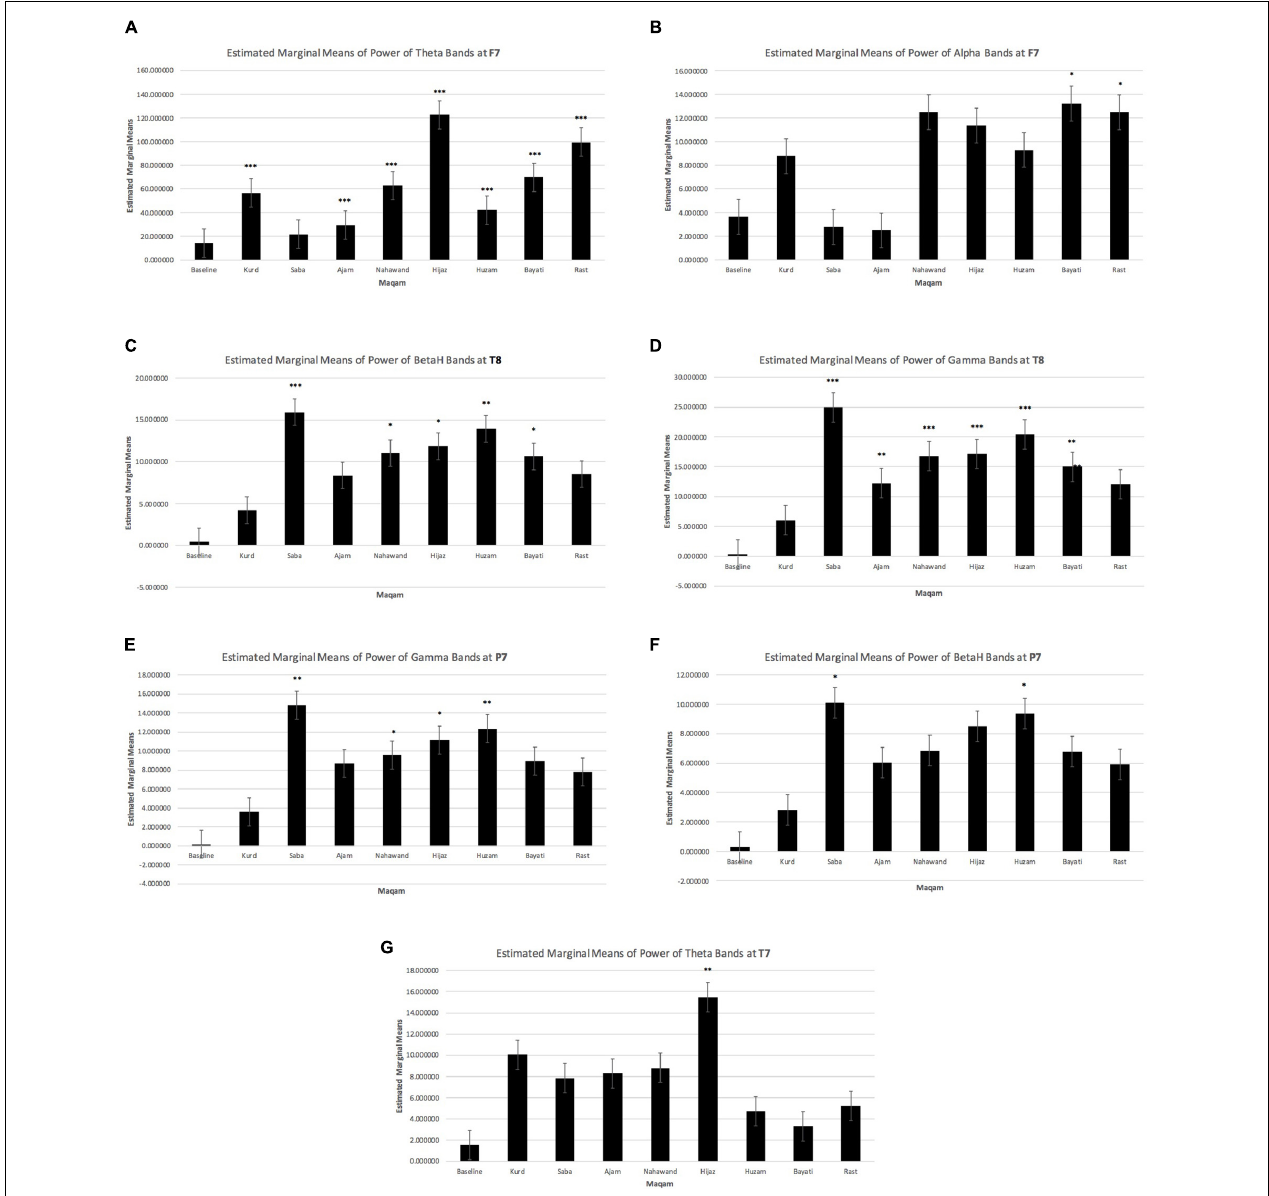
FIGURE 2 | Left fronto-temporal increase of low frequency bands and parietal left and temporal right increase of high frequency bands during improvisations for each maqam as compared to the baseline. (A) Theta bands at F7. (B) Alpha bands at F7. (C) Beta high bands at T8. (D) Gamma bands at T8. (E) Gamma bands at P7. (F) Beta high bands at P7. (G) Theta bands at